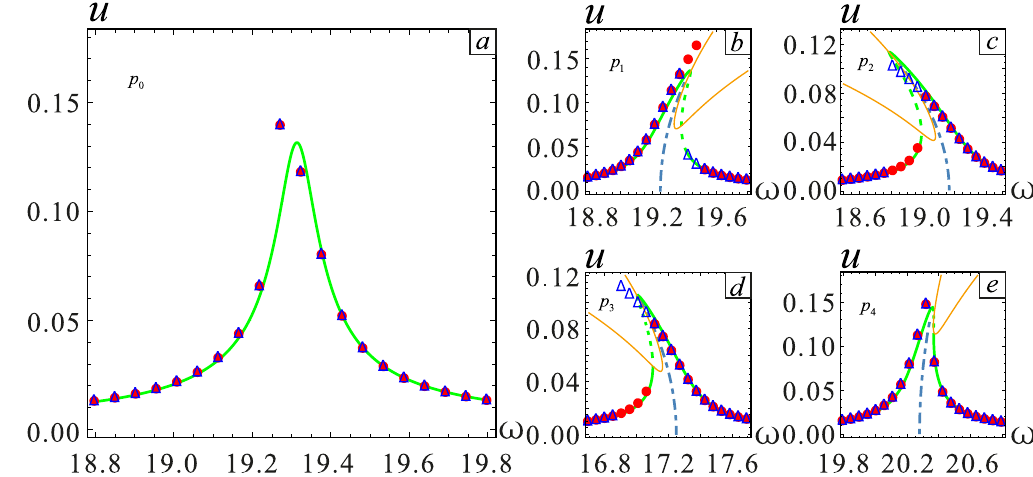
Figure 6. Frequency response curve in different situations, i.e., corresponding to cases P 0 , P 1 , P 2 , P 3 and P 4 . ( a ) is the case of P 0 . ( b ) is the case of P 1 . ( c ) is the case of P 2 . ( d ) is the case of P 3 . ( e ) is the case of P 4 . The solid lines represent stable solutions. The dashed lines represent unstable solutions. The point represents the numerical solution.